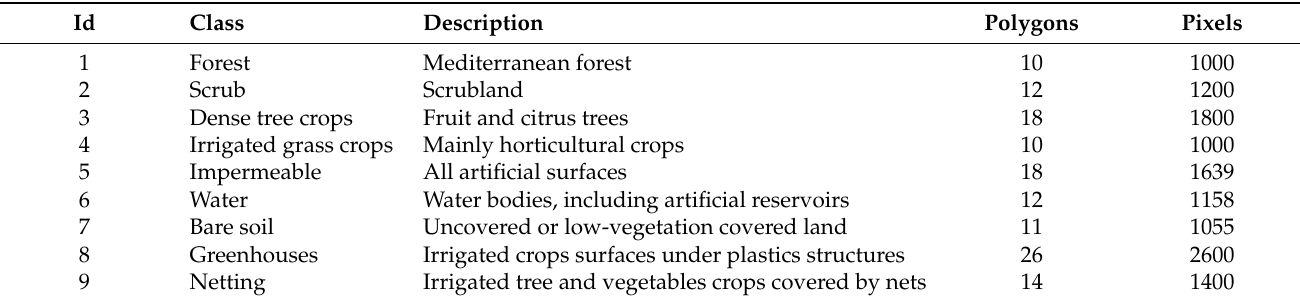
Table 4. Land covers taken into account in the classification, including the number of polygons for training and validation and number of total pixels per